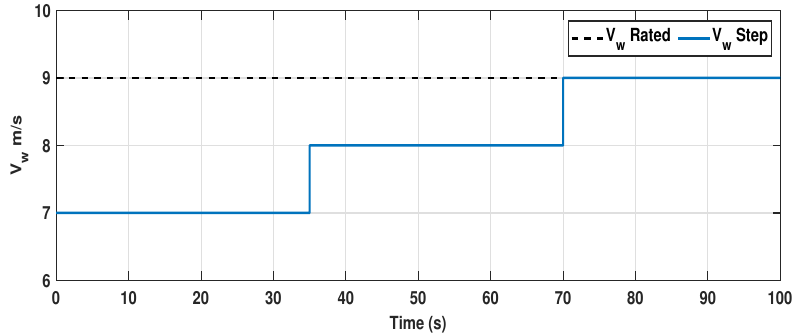
Figure 4. Step-varying wind profile used for region II operation.